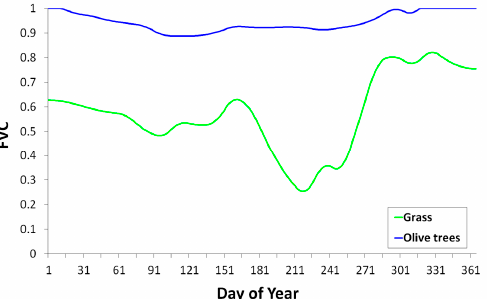
Figure 7. FVC evolutions of grass and olive trees at the Cascine site obtained from Sentinel-2 MSI NDVI images during the year 2021.